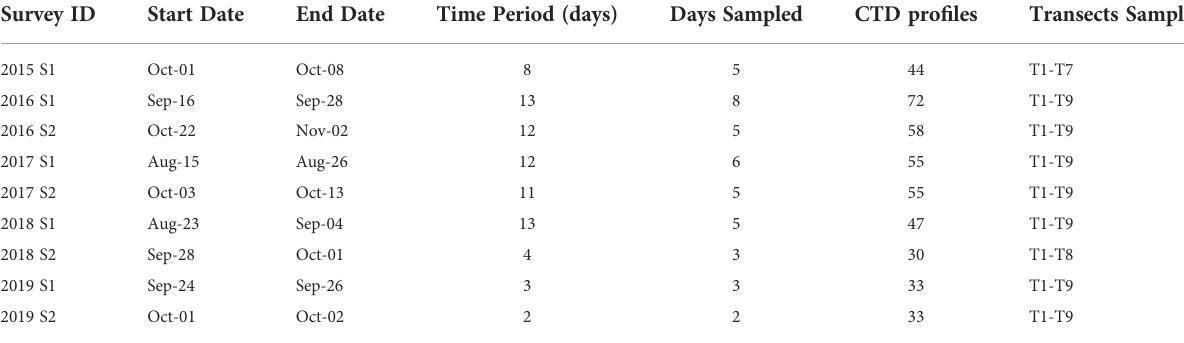
TABLE 1 Metadata and timing for each of the boat-based